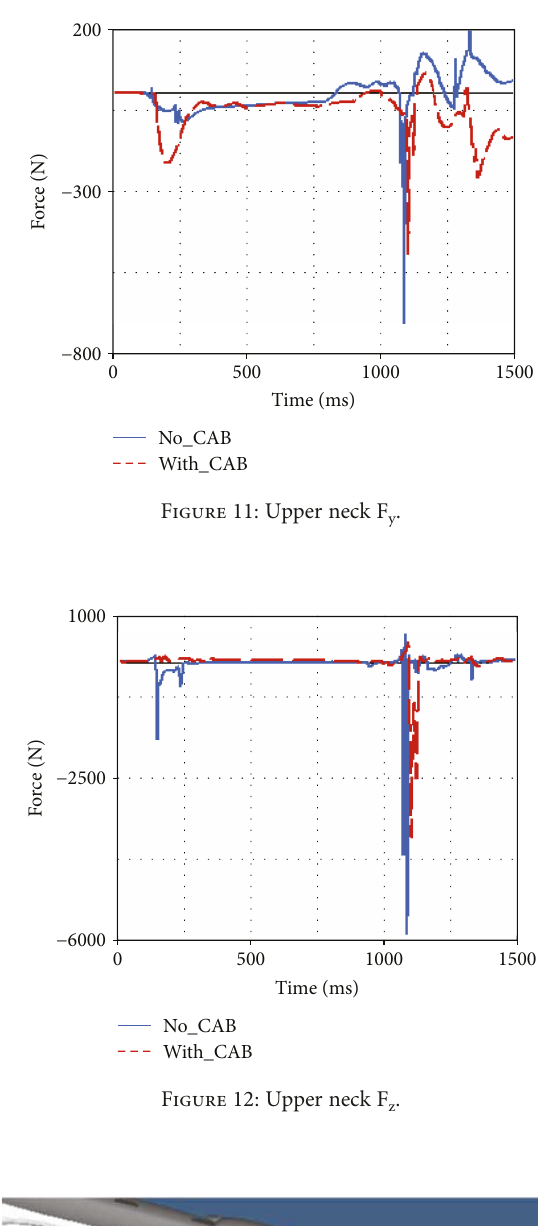
Figure 9: Pelvis resultant accelerations.